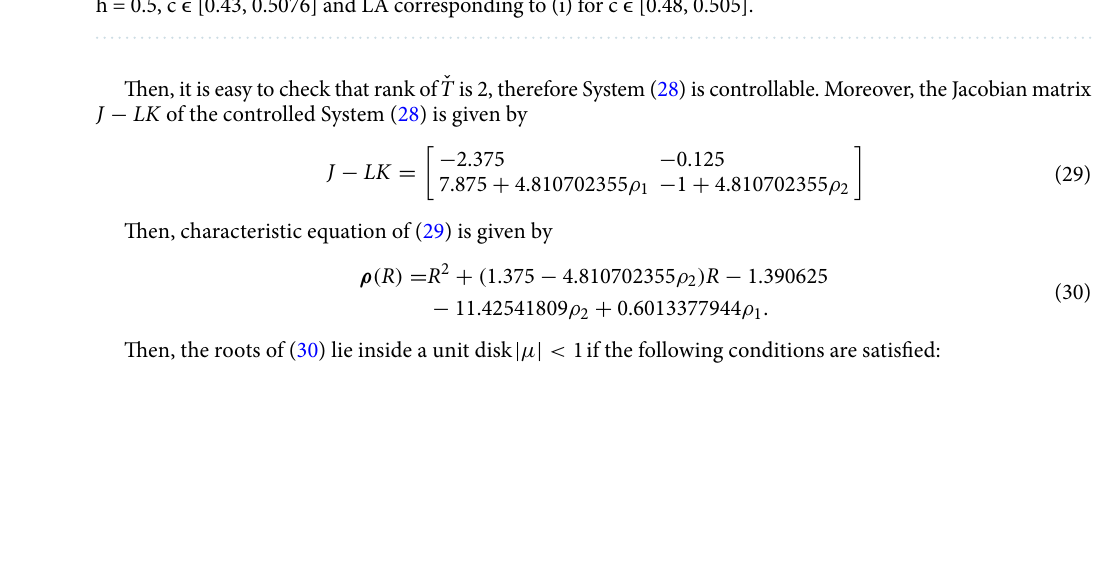
Figure 16. Bifurcation diagrams and ML exponents for the model (i) for values of a = 0.5, b = 1.5, e = 1.2, h = 0.5, c ϵ [0.43, 0.5076] and LA corresponding to (i) for c ϵ [0.48,